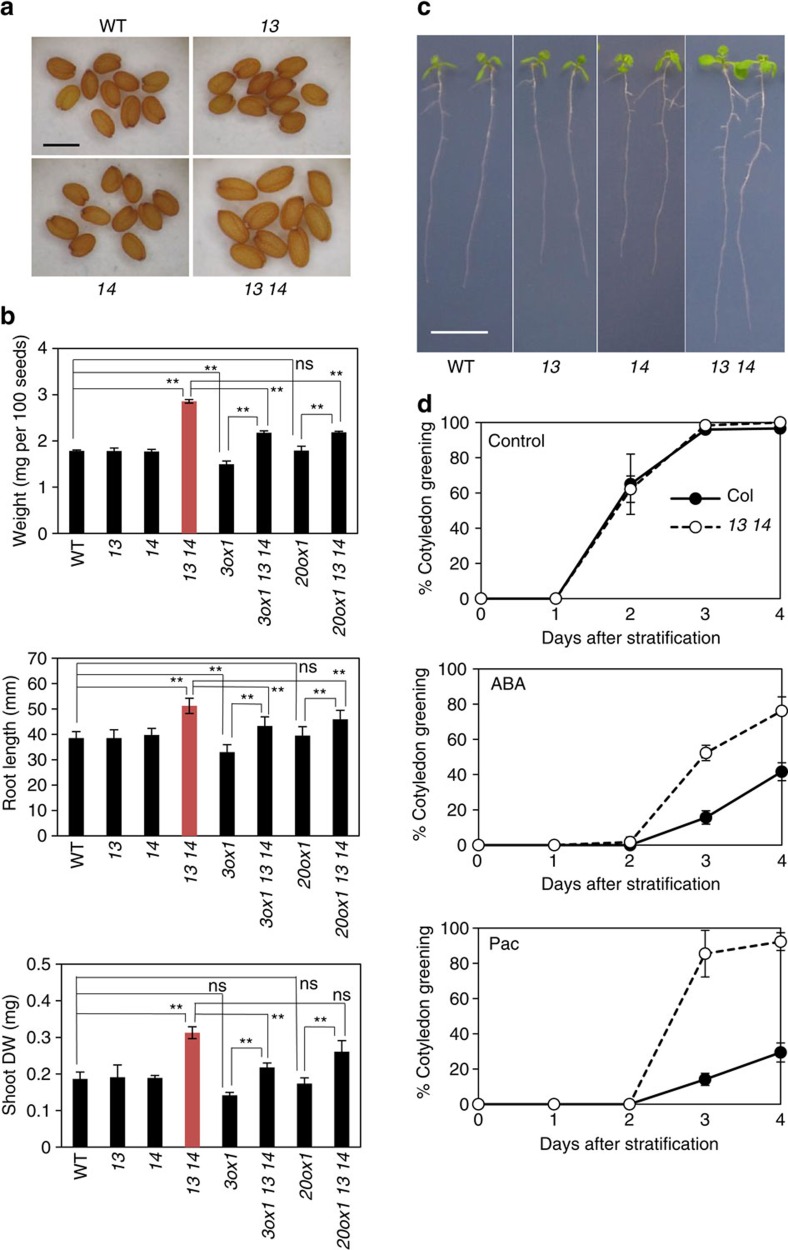
Phenotypes of sweet13 sweet14 in seeds and seedlings.(a) Dry seeds of wild type (WT), sweet13 (13), sweet14 (14), and sweet13 sweet14 (13 14). Scale bar, 0.5 mm. (b) Phenotypes of wild type (WT), sweet13 (13), sweet14 (14), sweet13 sweet14 (13 14), ga3ox1 (3ox1), ga3ox1 sweet13 sweet14 (3ox1 13 14), ga20ox1 (20ox1), and ga20ox1 sweet13 sweet14 (20ox1 13 14). Upper panel: weight for 100 dry seeds was measured independently three times for each genotype and the average values are shown with standard deviations. Middle panel: root length of 8-day-old seedlings grown on Murashige and Skoog media without sugars (averages of 40–50 seedlings) is shown with ±s.d.. Lower panel: shoot dry weight of 13–20 seedlings that were grown for 8 days on Murashige and Skoog media without sugars was measured and the weight per shoot was calculated. Values are means±s.d. of three biological replicates. **P<0.001; ns, not significant (P>0.05); Tukey–Kramer test. (c) Seedlings of (WT), sweet13 (13), sweet14 (14), and sweet13 sweet14 (13 14) grown for 8 days on Murashige and Skoog media without sugars. Scale bar, 1 cm. (d) Germination of wild type (WT) and sweet13 sweet14 (13 14) in the presence or absence of 0.5 μM ABA or 10 μM paclobutrazol (Pac). Germination rates of approximately 50 seeds were scored every day and averages of three biological replicates are shown with standard deviations. Cotyledon greening was the indicator of germination.